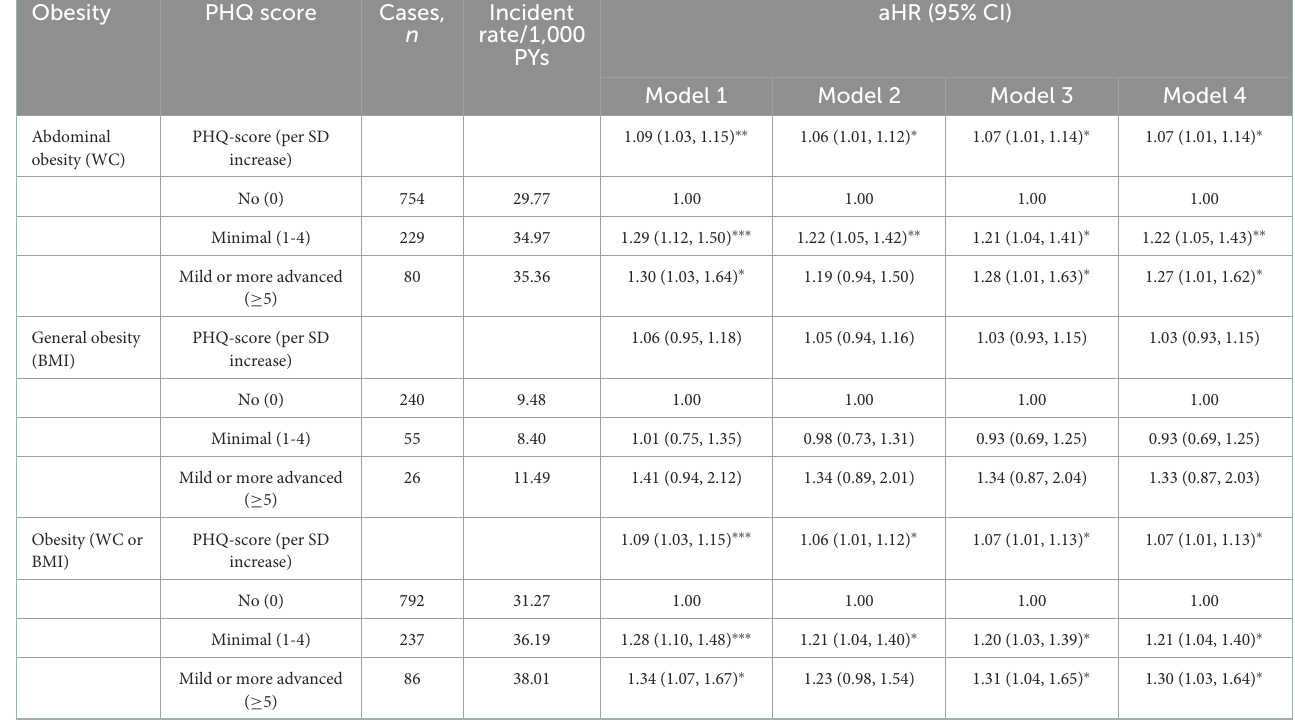
TABLE 2 Associations between depression at baseline and incident obesity among Chinese adults. Obesity PHQ score Cases, n